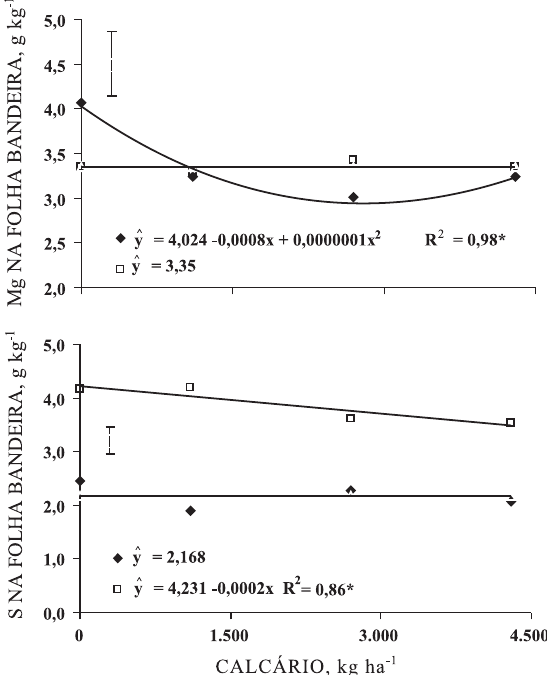
Figura 2. Teores Mg e S na folha bandeira de aveia- preta em função da aplicação de calcário em superfície, sem ( ) e com ( ) a aplicação de gesso, no ano de 2003. * é significativo a 5 % pelo teste t. Barras verticais indicam o valor de DMS pelo teste t (p =